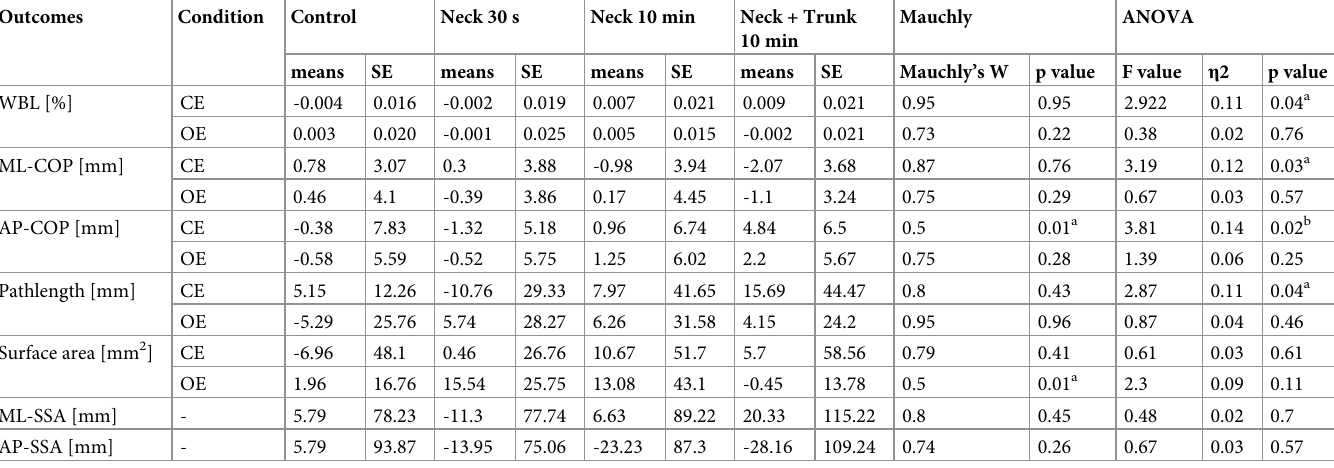
Table 1. The results of one-way analysis of variance with repeated measures. Outcomes